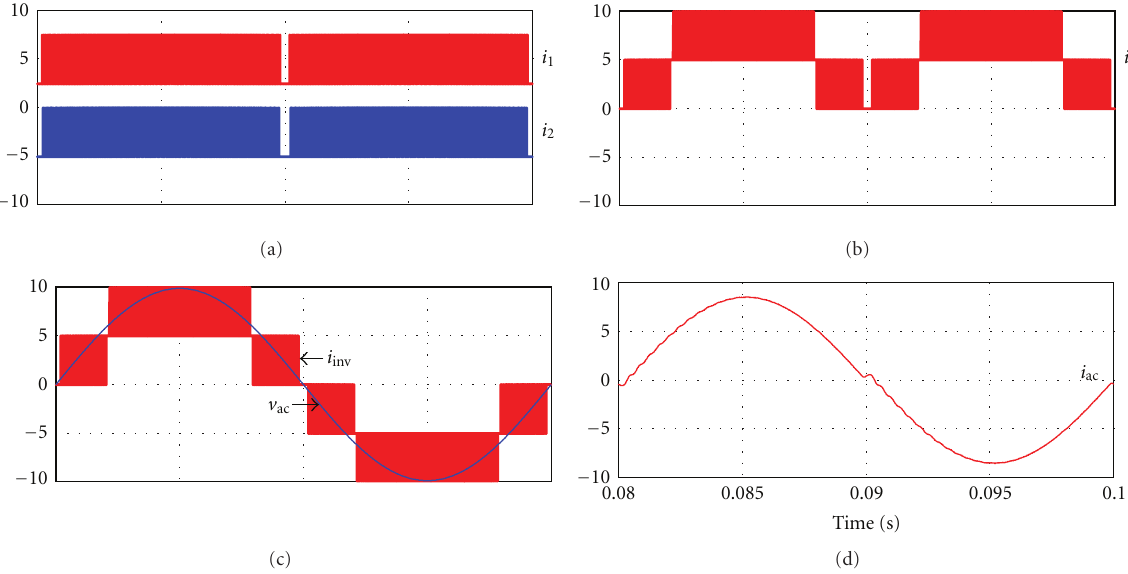
Figure 17: Simulated waveforms of the hybrid PV/wind system with phase-shifted PWM operating under the conditions of m pv = m wind , f I = I = 50 Hz and f pv wind , line